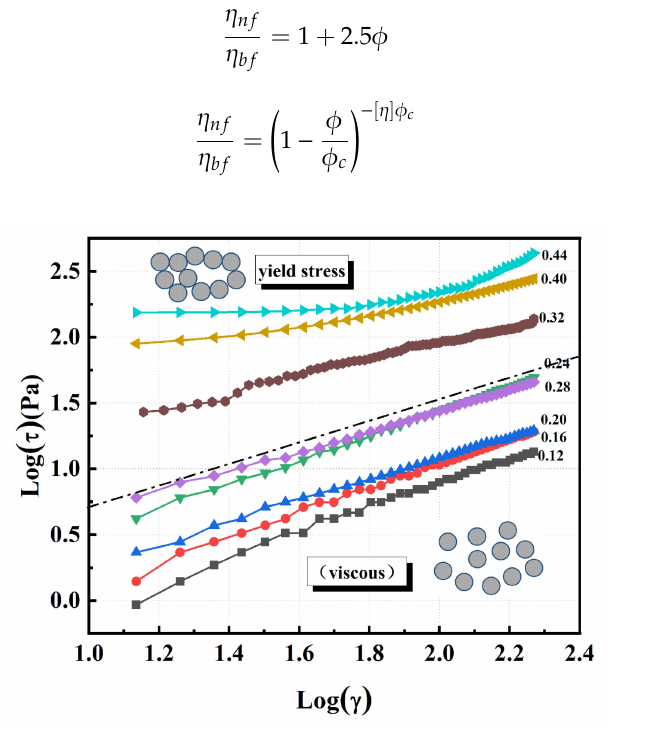
Figure 10. The logarithmic plot of the power law for 5 wt.% PVP stabilized suspensions. The inset presents an illustration of the particle distribution